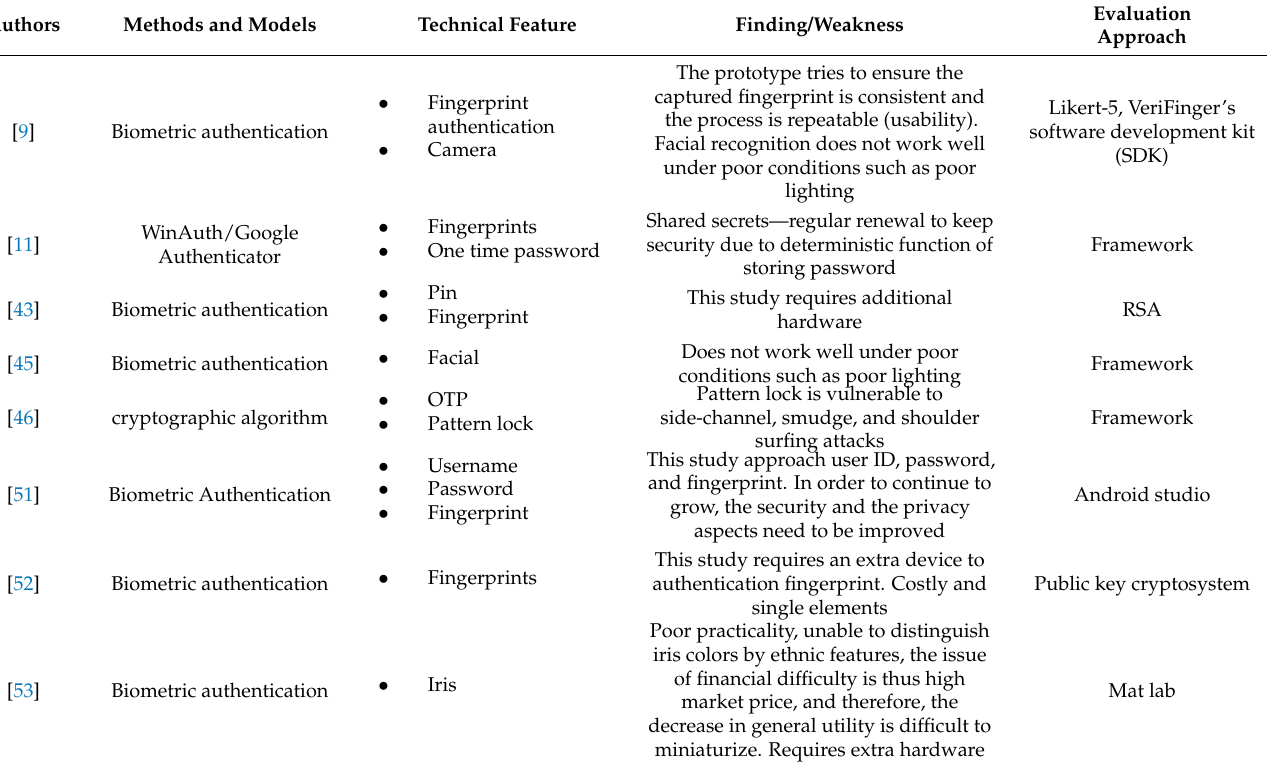
Table 1. Work related to